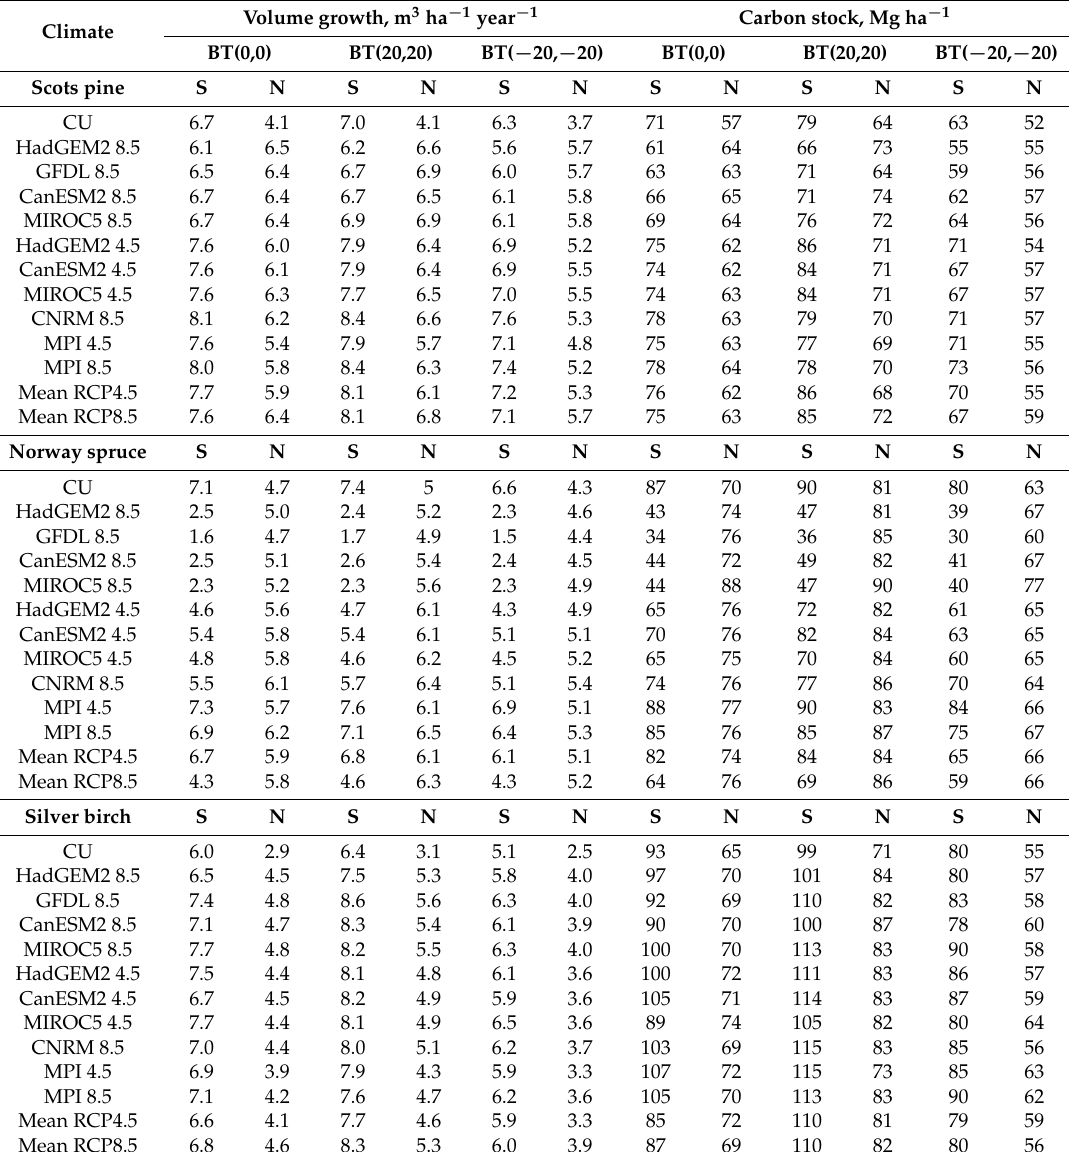
Table A2. Mean annual volume growth (m 3 ha − 1 year − 1 ) and total ecosystem carbon stock (Mg ha − 1 ) over a 90-year simulation period in Scots pine, Norway spruce and birch stands on medium fertile sites in southern and northern Finland under the current climate (CU) and different climate change projections and management scenarios. S = south, N = north.